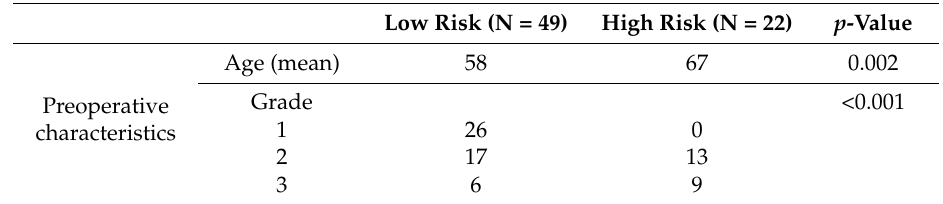
Table A5. Patient clinical and pathological characteristics for GEO17025 patients (N = 71). Univariate analysis with logistic regression was used to assess differences between both